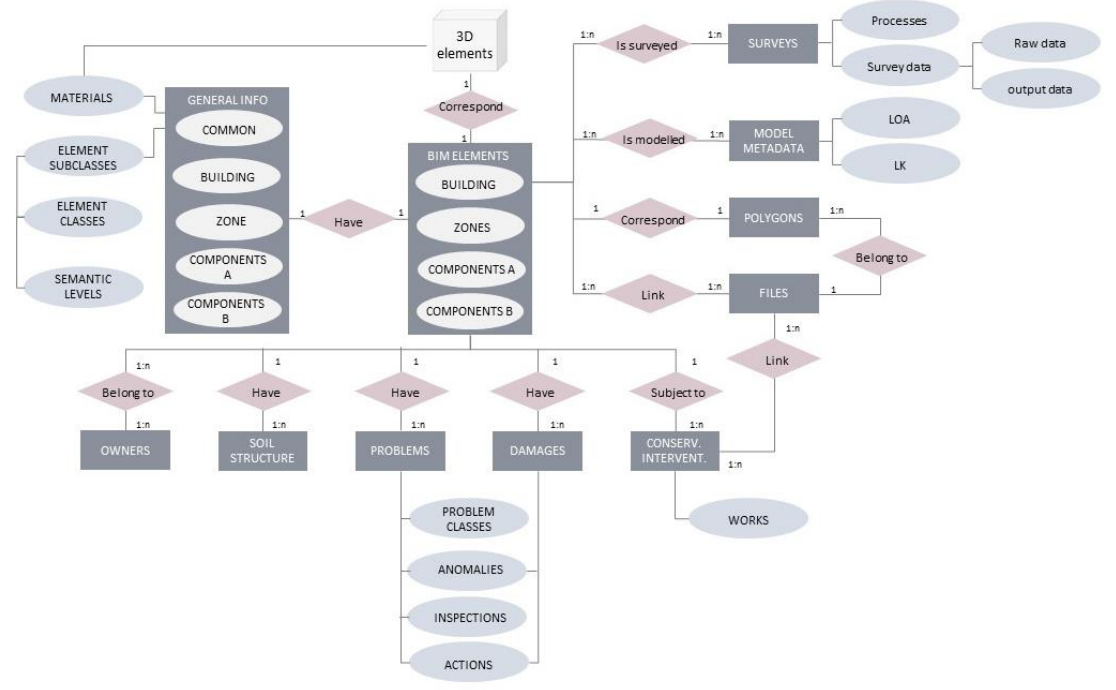
Figure 3. Entity—relationships database schema.